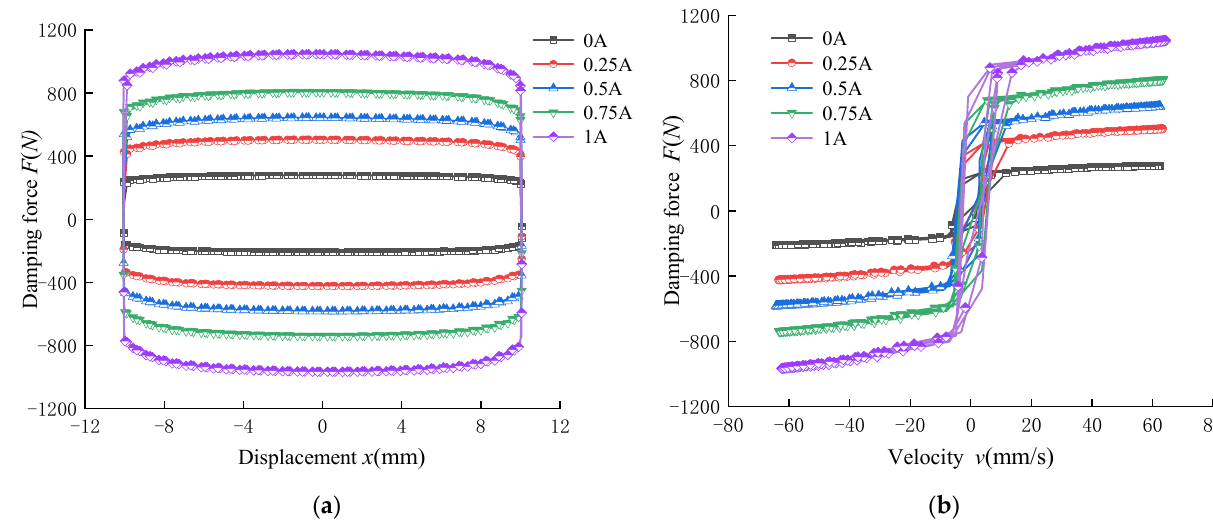
Figure 2. Mechanical characteristics of MR damper. ( a ) Force displacement, and ( b ) force velocity.